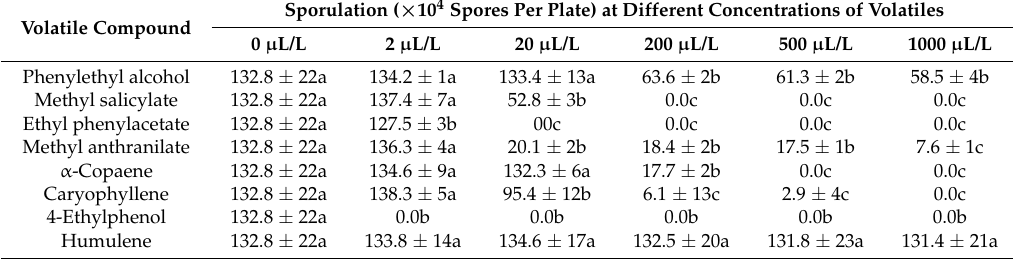
Table 6. Effect of volatile compounds on P. litchii sporulation.